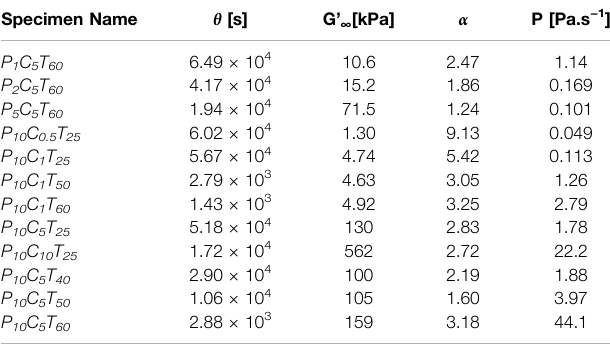
TABLE 1 | Fitting parameters using modi fi ed Hill equation.